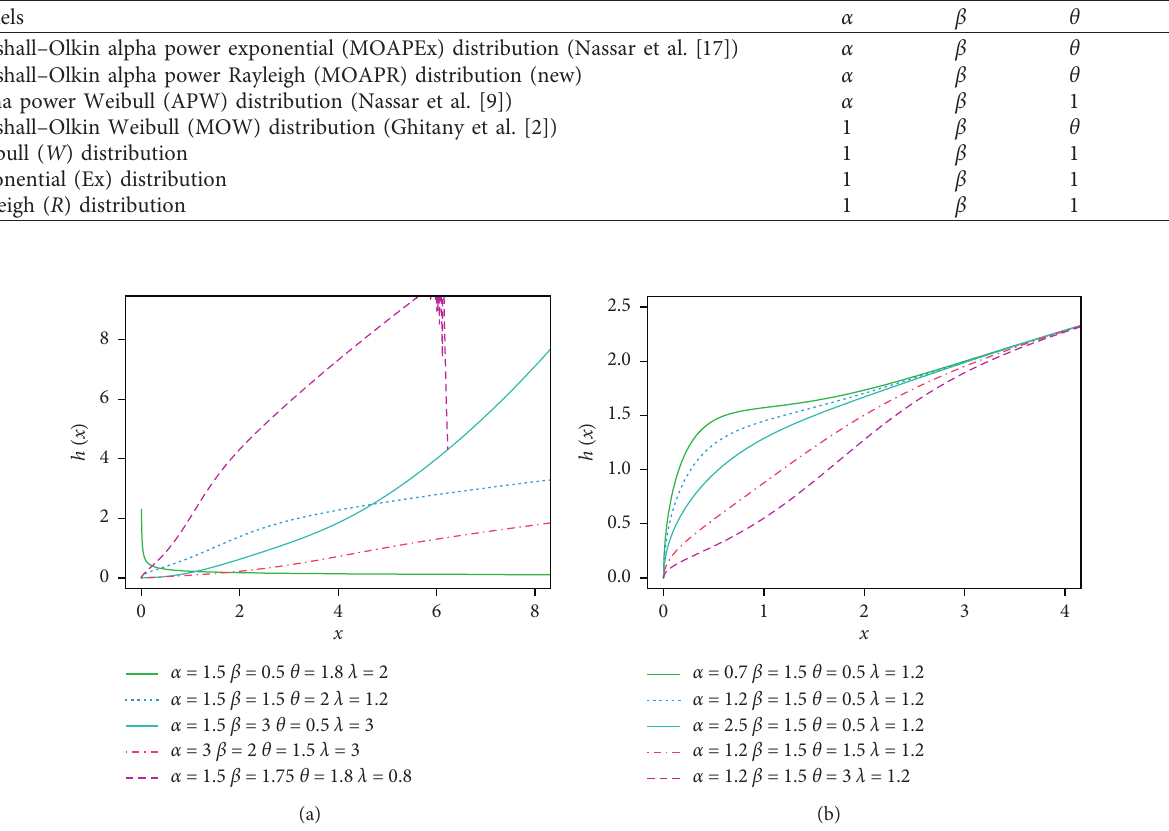
Table 1: Submodels from MOAPW distribution.